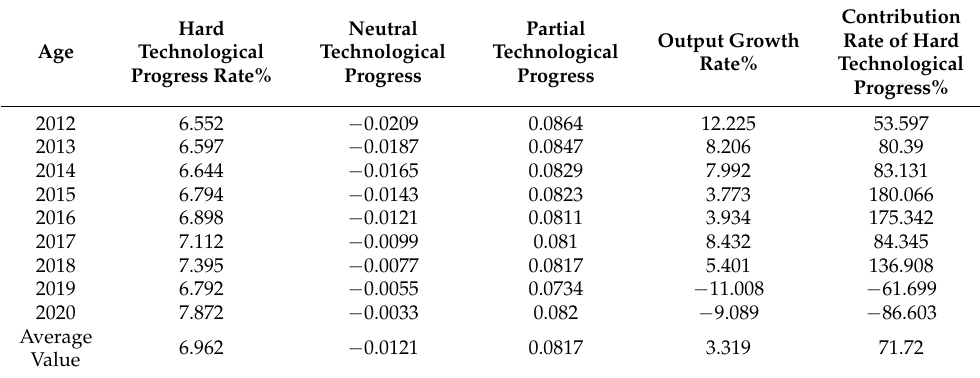
Table 3. Progress rate and contribution rate of aquaculture hard technology in China from 2012 to